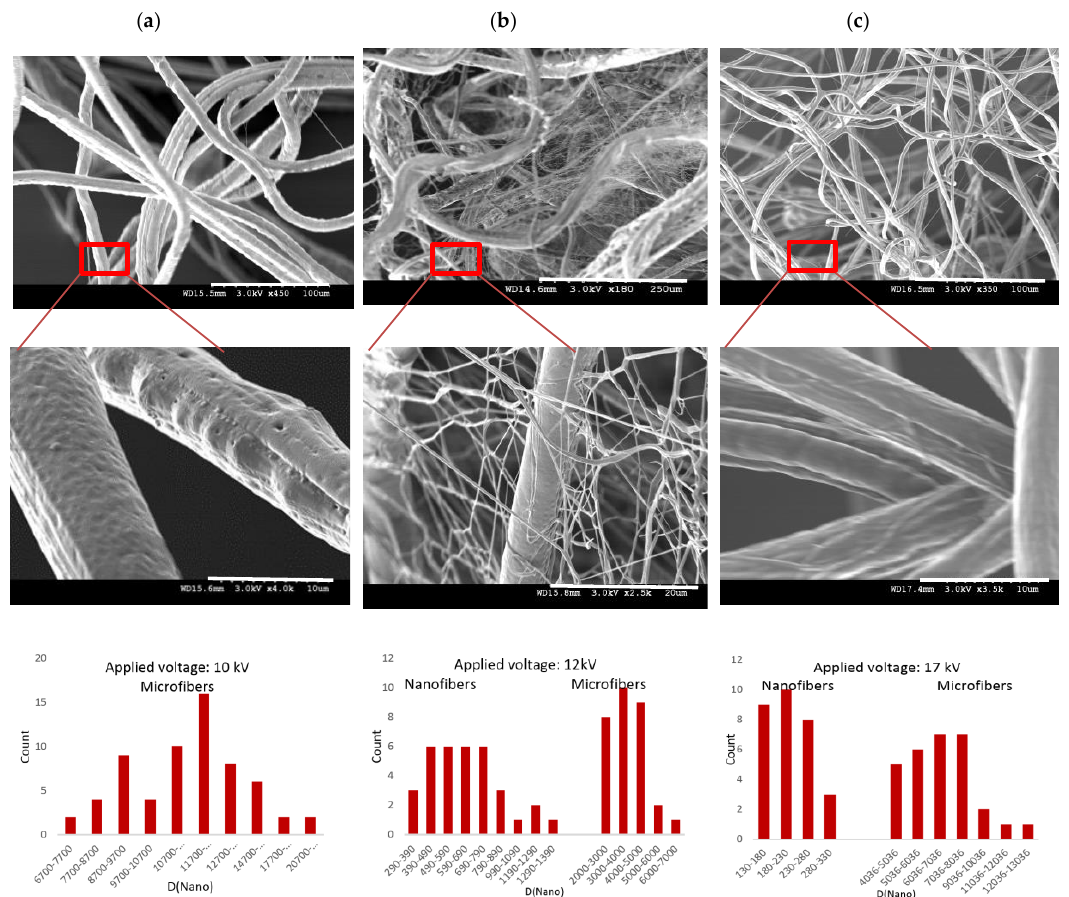
Figure 3. SEM micrographs with varied magnificent for more clarity and associated fiber diameter intensity of the electric field from left to right; ( a ) Microfibers with non-uniform surface (10 kV); ( b ) Micro and nano fibrous network (12 kV); ( c ) Micro and nanofibers that mostly stuck to each other (17